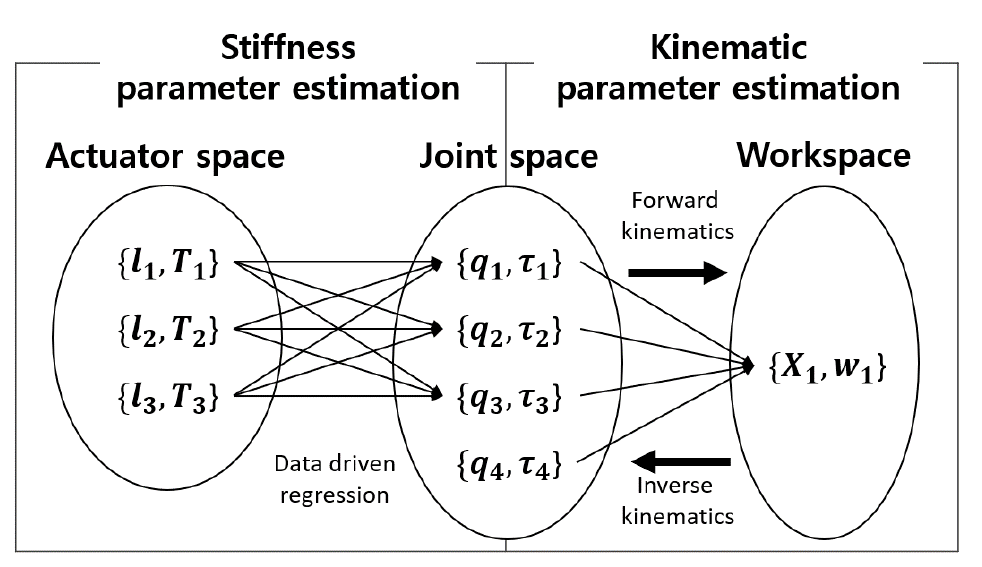
Figure 6. Schematic diagram to show purpose of kinematic identification and stiffness parameters estimation. Stiffness parameter estimation elucidates the relationship between the joint angle and the actuation data. The main purpose of stiffness parameter estimation is to obtain the relationship between the joint and the end-effector; this is highly related to kinematic